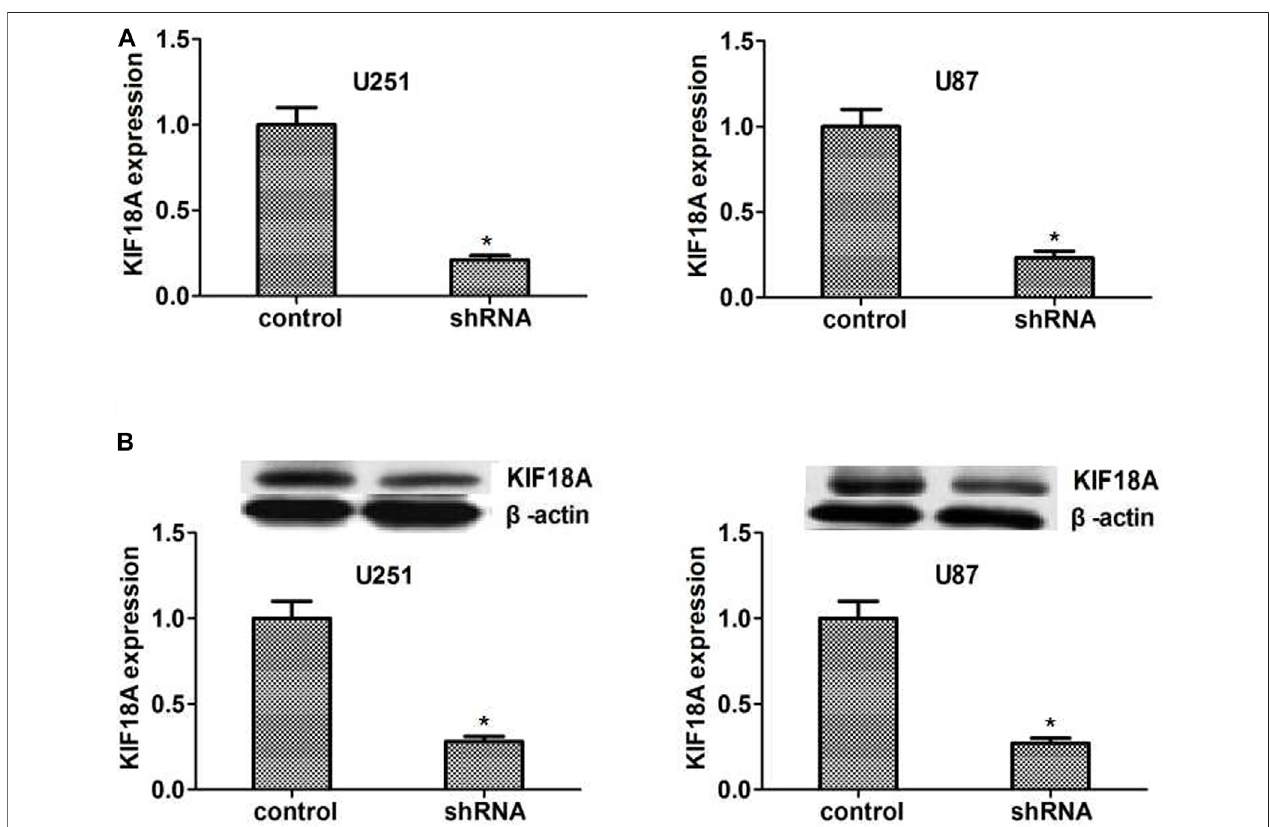
FIGURE 4 | KIF18A was effectively knockdown in U251 and U87 cells caused by the shRNA transfection. (A, B) The qPCR assay results showed that the expression of KIF18A was signi fi cantly decreased in U251 and U87 cells, respectively. Immunoblot analysis revealed that KIF18A was signi fi cantly absent in U251 and U87 cells. Results are expressed as overall standard deviation, * p <